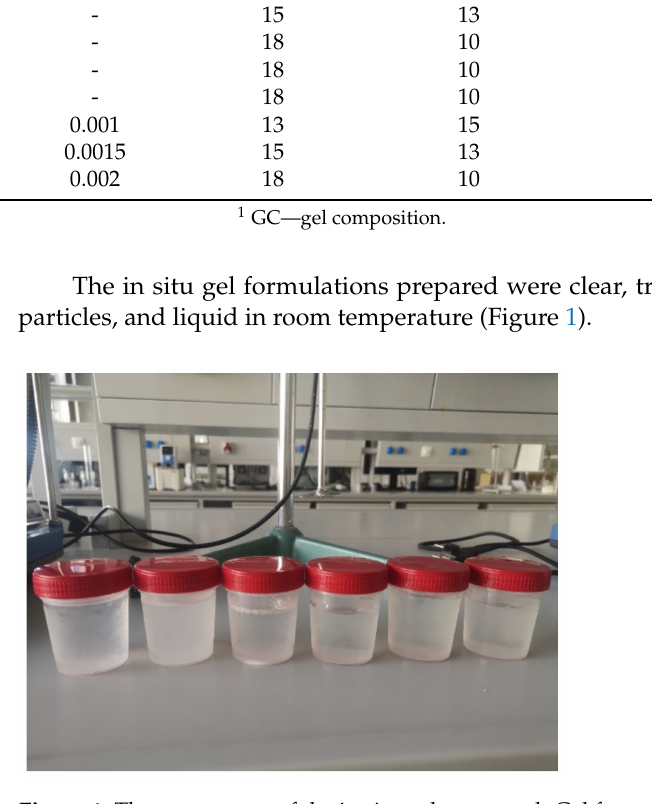
Figure 1. The appearance of the in situ gels prepared. Gel formulations N1–N6 (left to right). After the preparation of in situ gels, the quality determination was performed. The results of the determination of physicochemical parameters of prepared in situ gels are indicated in Table